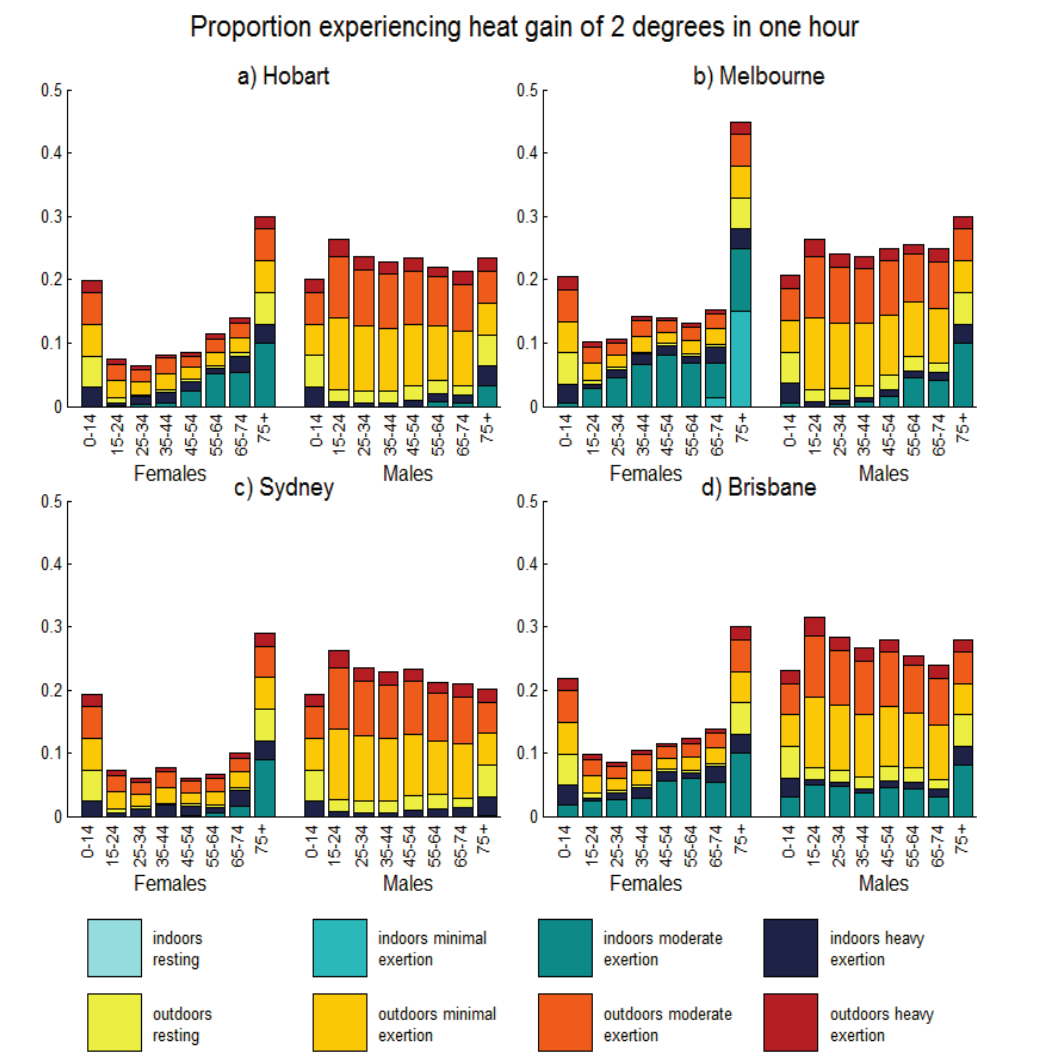
Figure 3. The proportion of each age-sex group that gains 2 °C or more in one hour at weather conditions recorded at 3:00 p.m. on the day with most extreme conditions in January 2014 for each of four Australian cities, assuming no modification in behavior due to the weather. Age and sex groups are classified as those indoors or outdoors, with increasing levels of exertion. For Hobart, the day plotted was the 28 January (36.5 °C temperature, 15% humidity, 595 W·m − 2 solar radiation), for Melbourne it was the 16 January (43.2 °C temperature, 16% humidity, 600 W·m − 2 solar radiation), for Sydney it was the 29 January (29 °C temperature, 45% humidity, 713 W·m − 2 solar radiation), and for Brisbane it was the 4 January (35.5 °C temperature, 47% humidity, 706 W·m − 2 solar radiation). Risk in males is exacerbated by solar radiation, with men indoors typically only at risk during extreme heat (Melbourne) or when humidity is high (Brisbane). In contrast, there is a clear risk to older females indoors at both moderate and high exertion levels, with risk extending to minimal exertion levels for females aged 75 and older under extreme heat (Melbourne). Children typically have a high surface area to mass ratio, which makes for efficient heat loss when air temperatures are below skin temperatures, however this gradient can be reversed during extreme heat [51]. Likewise, a high surface area to